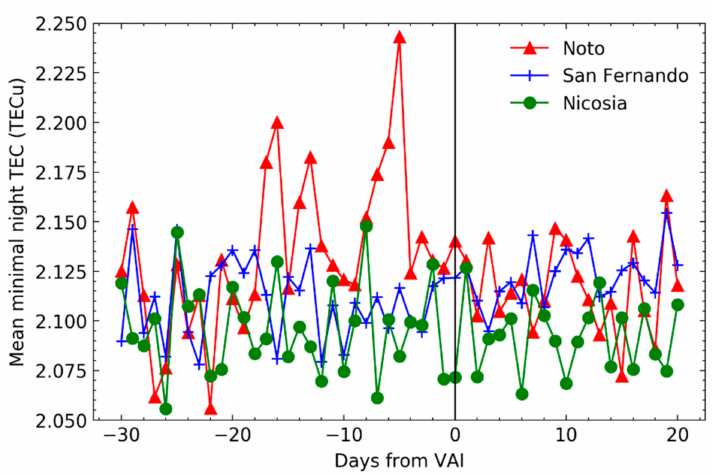
Figure 8. TEC patterns on IGS Noto, IGS San Fernando and IGS Nicosia during index days for the Criteria C. The vertical line denotes the day of defined volcanic activity increase